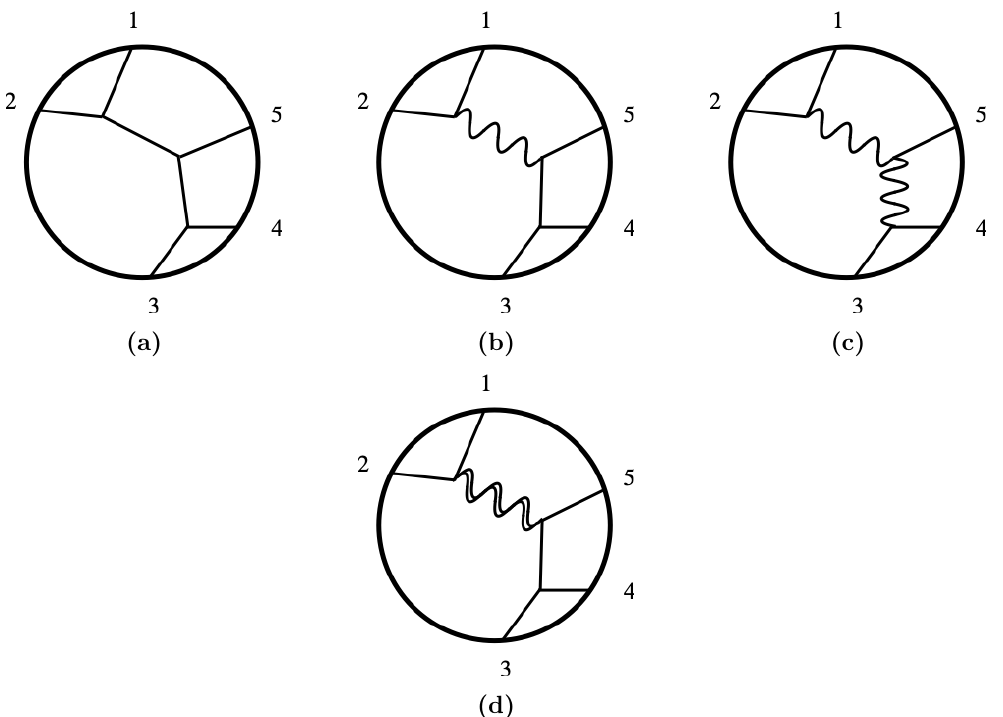
Figure 2. The four types of double-exchange Witten diagrams allowed by R-symmetry selection rules. The straight, curly and double curly lines correspondingly represent the scalar, graviphoton and graviton (cid:12)eld.